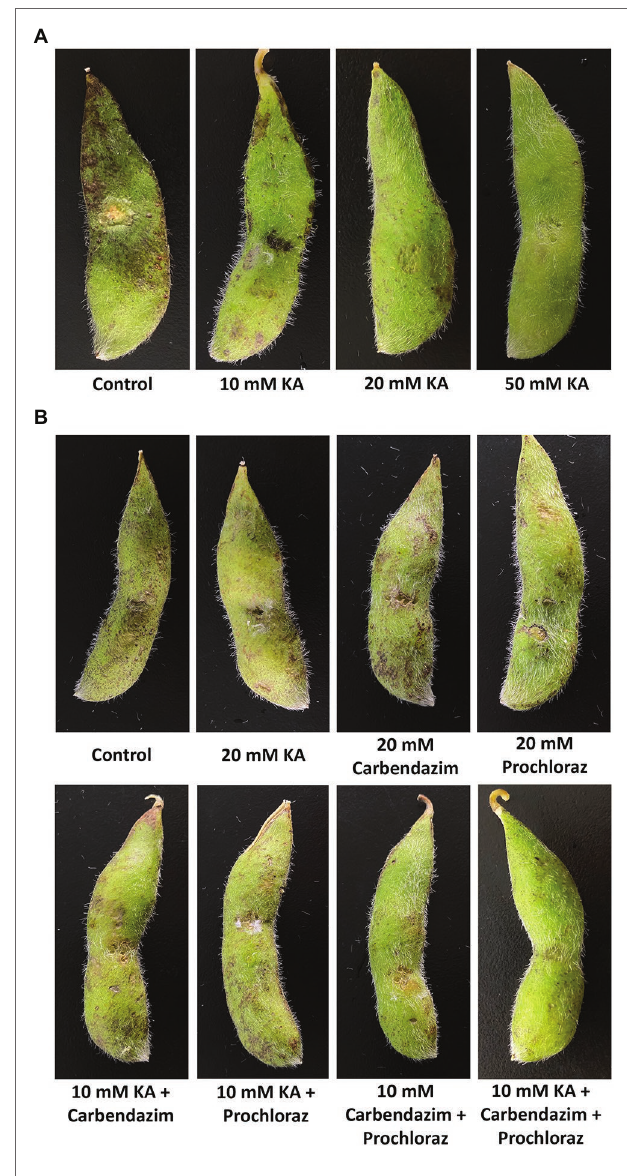
FIGURE 5 | Efficacy of KA and some commercial fungicides for the control of Sclerotinia sclerotiorum in soybean pods. (A) Preventive applications. (B) Curative